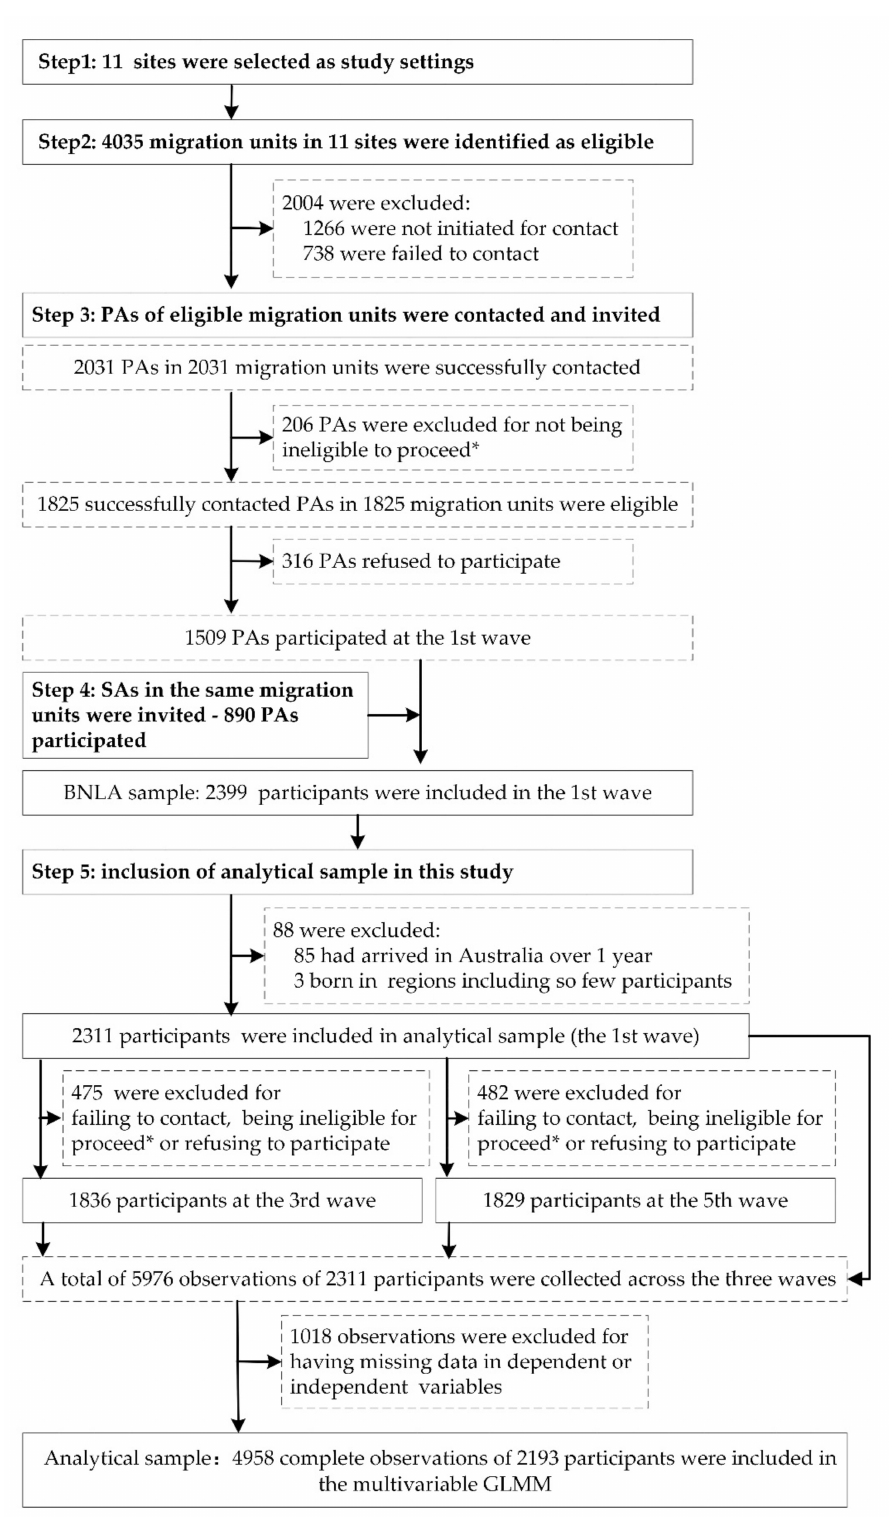
Figure 1. Flow chart of the sampling. Note: context in solid boxes are sampling steps and sampling outcomes at each step, where sampling steps are bold; context in dashed boxes are detailed operation of each step. * Ineligible for proceed: successfully contacted but could not proceed with an interview for reasons, such as the quota was met, moved to an area outside the scope of interviewing, or unavailable for the duration of the fieldwork period. GLMM: generalized linear mixed model, PAs: principal applications, SAs: secondary